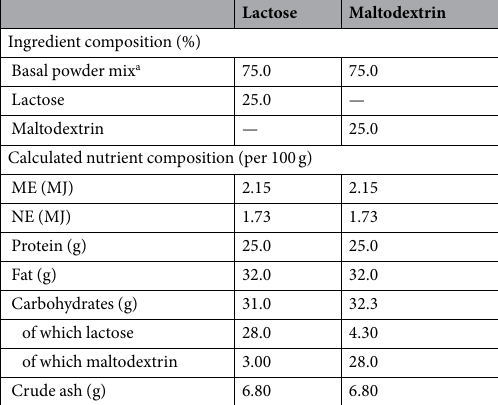
Table 1. Ingredient and nutrient compositions of the experimental milk powders. a Composition (% relative to total ingredient composition of the experimental milk powders): fat concentrate I (80% coconut oil on maltodextrin), 13%; fat concentrate II (80% palm oil on sweet whey), 24.65%; WPC-75%CP, 25%; wheat protein hydrolysed, 5.02%; Di-potassium phosphate 17.7%P, 1.5%; citric acid, 1%; sodium chloride, 1%; calcium carbonate, 0.75%; premix, 0.50%; calcium formate, 0.50%; calcium acetate, 0.50%; magnesium sulphate, 0.50%; potassium sorbate, 0.34%; L-lysine HCL 98%, 0.30%; DL-methionine 99%, 0.20%; silica, 0.06%; L-tryptophan 98%, 0.05%; sweetener, 0.03%; flavour, 0.03%; vitamin E, 0.02%; iron sulphate, 0.02%; L-threonine 98%, 0.01%; copper sulphate,